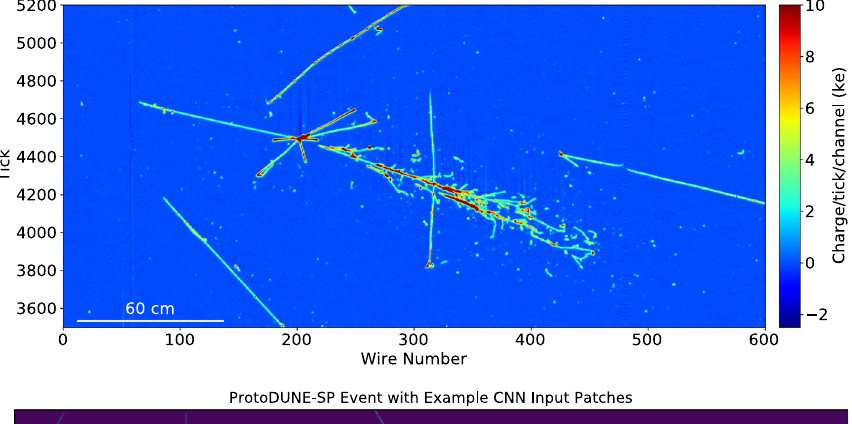
Fig. 2 Examples of CNN input patches from a simulated ProtoDUNE-SP event. The inputs to the CNN are small 48 × 48 pixel images created from patches of the full detector readout. Three examples are shown, each labelled with their appropriate class. The patch of the detector readout from which each patch was generated is